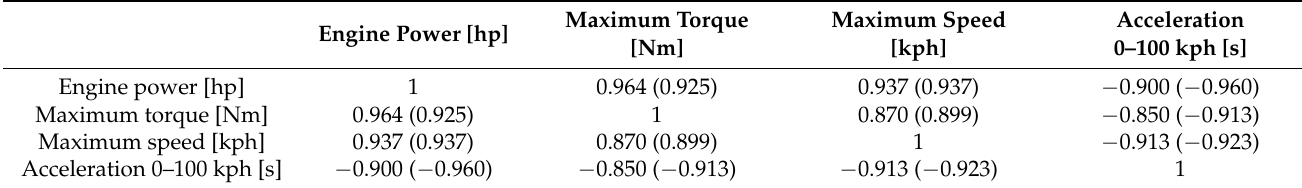
Table 6. The values of the correlation coefficients in performance